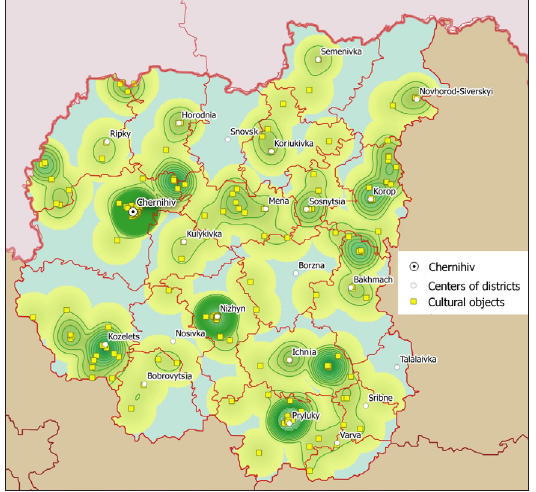
Figure 8. A heatmap of the distribution density of historical and cultural objects in Chernihiv